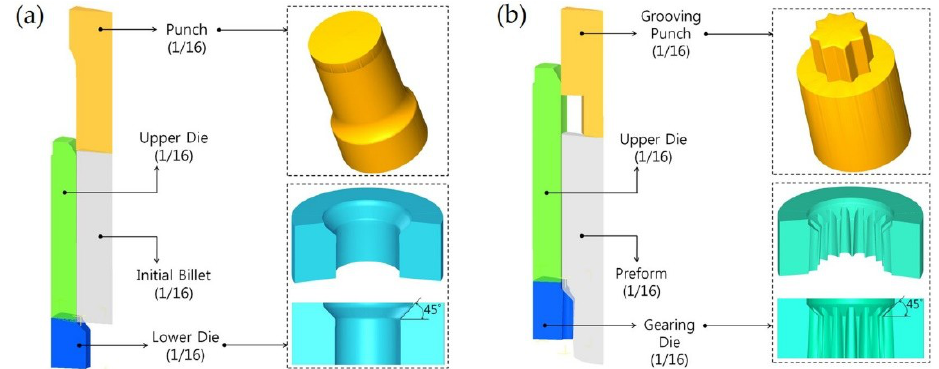
Figure 5. FE models applied to two-stage cold forging for producing the drive shaft: ( a ) FE model for preform forging; ( b ) FE model for forward-backward extrusion.